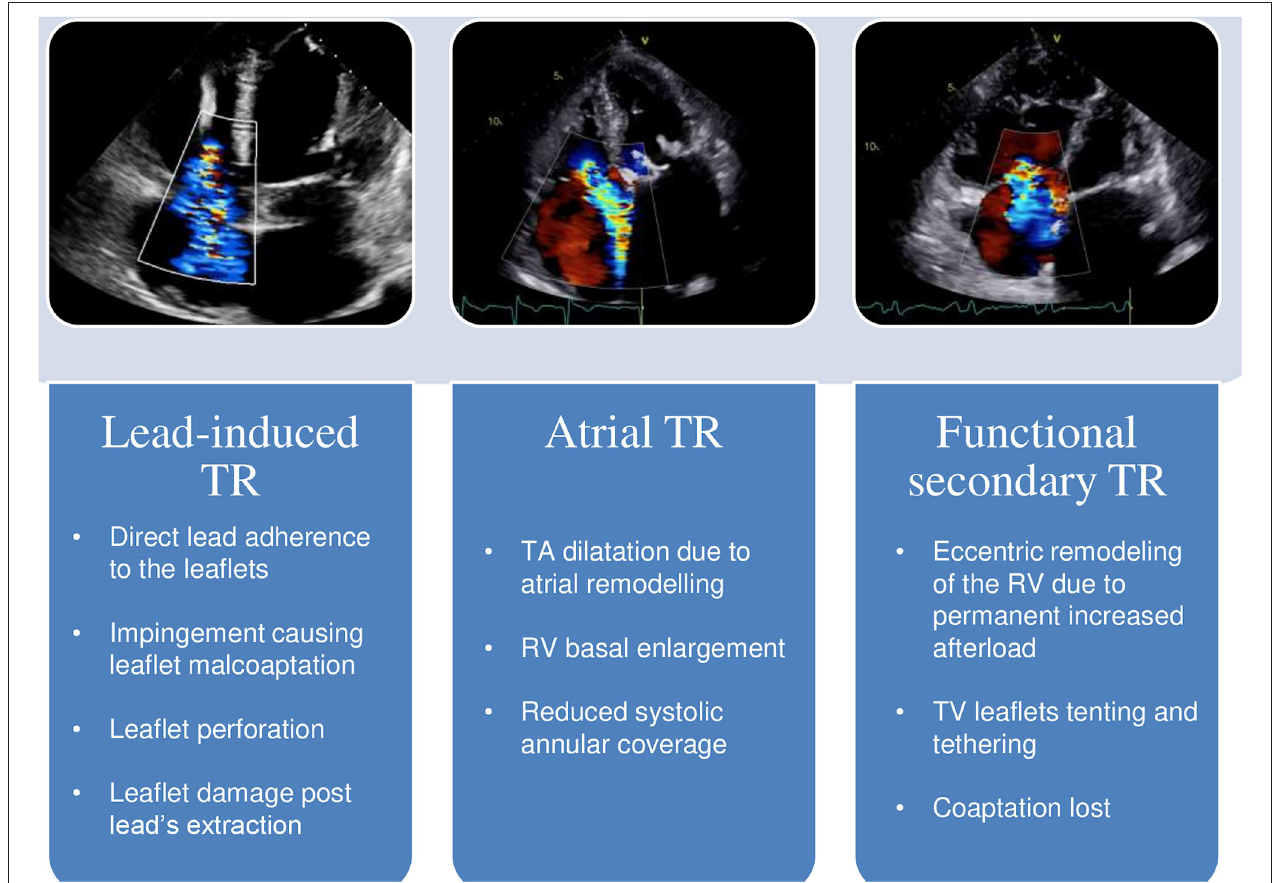
FIGURE 1 | Different mechanisms of TR in LV systolic dysfunction. In the panels above, transthoracic echocardiography color-doppler images; below, the main anatomic features of each related subtype. TA, tricuspid annulus; RV, right ventricle; TV, tricuspid valve; TR, tricuspid regurgitation; LV, left